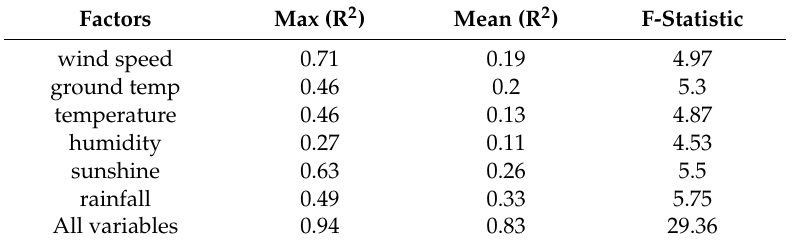
Table 5. Coe ffi cients of determinations and F-statistics for six environmental factors.